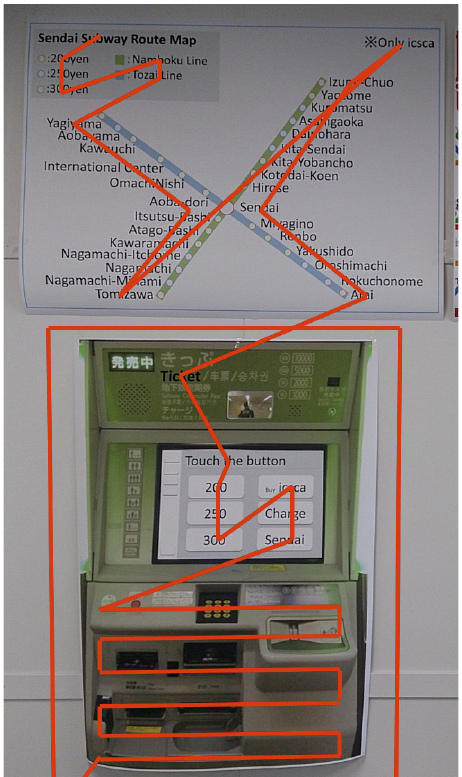
Figure 5. Viewpoints of training